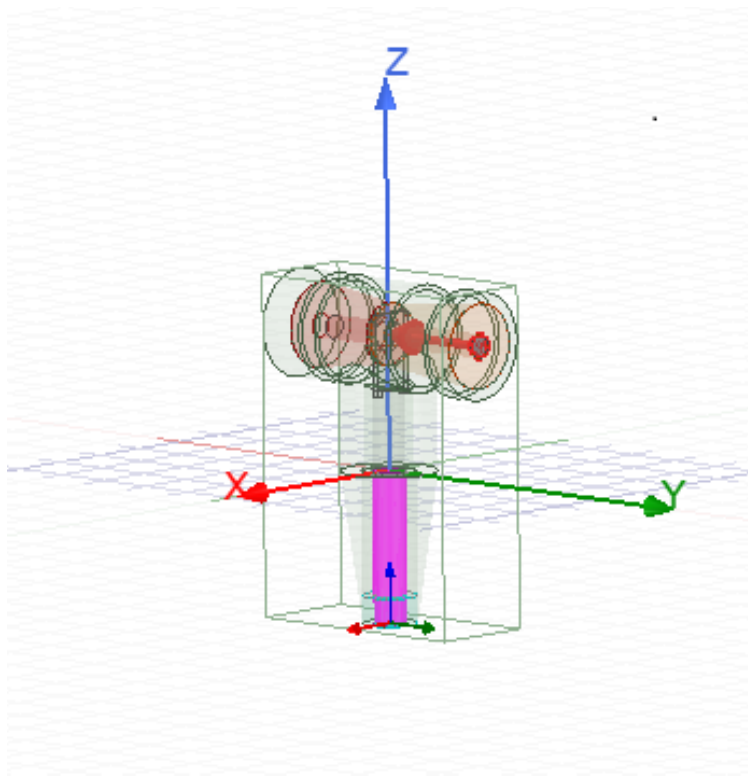
Figure 3. Numerical model of the head placed in the